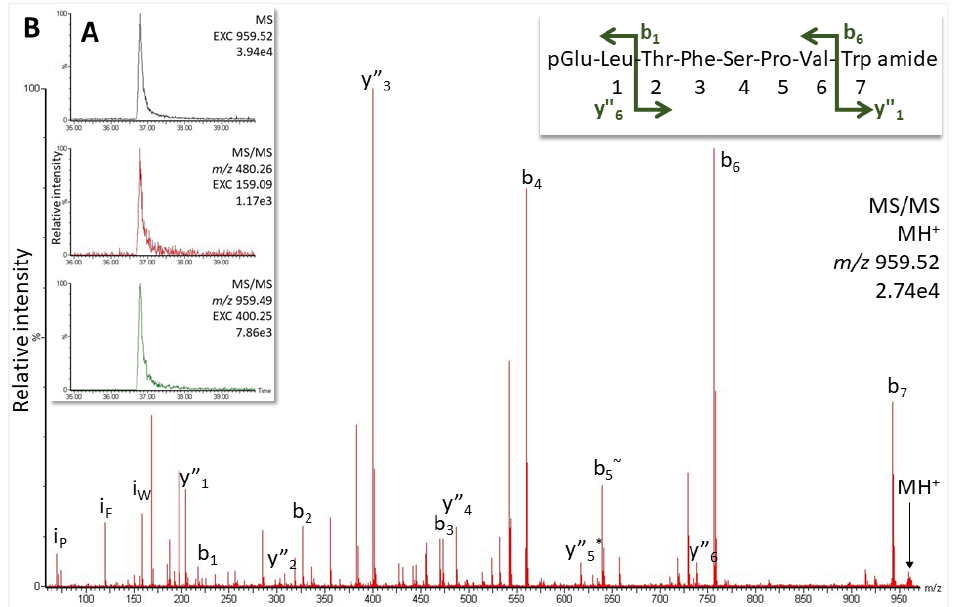
Figure 4. MS screening for potential AKHs in P. tapulus (1 µL injection, equivalent to the glandular content of 0.85 CC). ( A ) Extracted ion chromatograms (EXC), from the top: for the singly-charged peptide ion ( m/z 959.52) in the overview scan; for the Trp immonium ion in the MS/MS scan of the doubly-charged peptide ion ( m/z 480.26); and for the MS/MS of the singly-charged peptide ion on the dominant y 3 ion. ( B ) MS/MS spectrum of the singly-charged peptide ion. Peaks were labeled according to the b- and y-ion series as calculated in Supplementary Figure S5 for sequence pQLT- FSPVWa. For original spectrum also see Figure S5; for validation, see Figure S6.